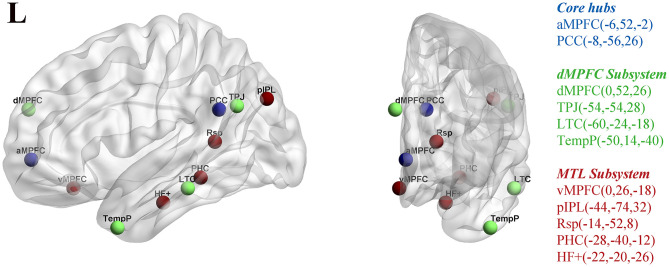
Eleven ROIs utilized in the rs-fMRI analysis for the midline core (blue), dorsal medial prefrontal cortex (dMPFC) subsystem (green), and the medial temporal lobe (MTL) subsystem (red) within DMN. The corresponding MNI coordinates for each ROI are shown on the right side of the picture. The regions were selected from a previous study (24). (ROI, regions of interest; DMN, default-mode network; PCC, posterior cingulate cortex; aMPFC, anterior medial prefrontal cortex; dMPFC, dorsal medial prefrontal cortex; TPJ, left temporo-parietal junction; LTC, lateral temporal cortex; TempP, temporal pole; MTL, medial temporal lobe; vMPFC, ventral medial prefrontal cortex; pIPL, posterior inferior parietal lobule; Rsp, retrosplenial cortex; PHC, parahippocampal cortex; HF, hippocampal formation).